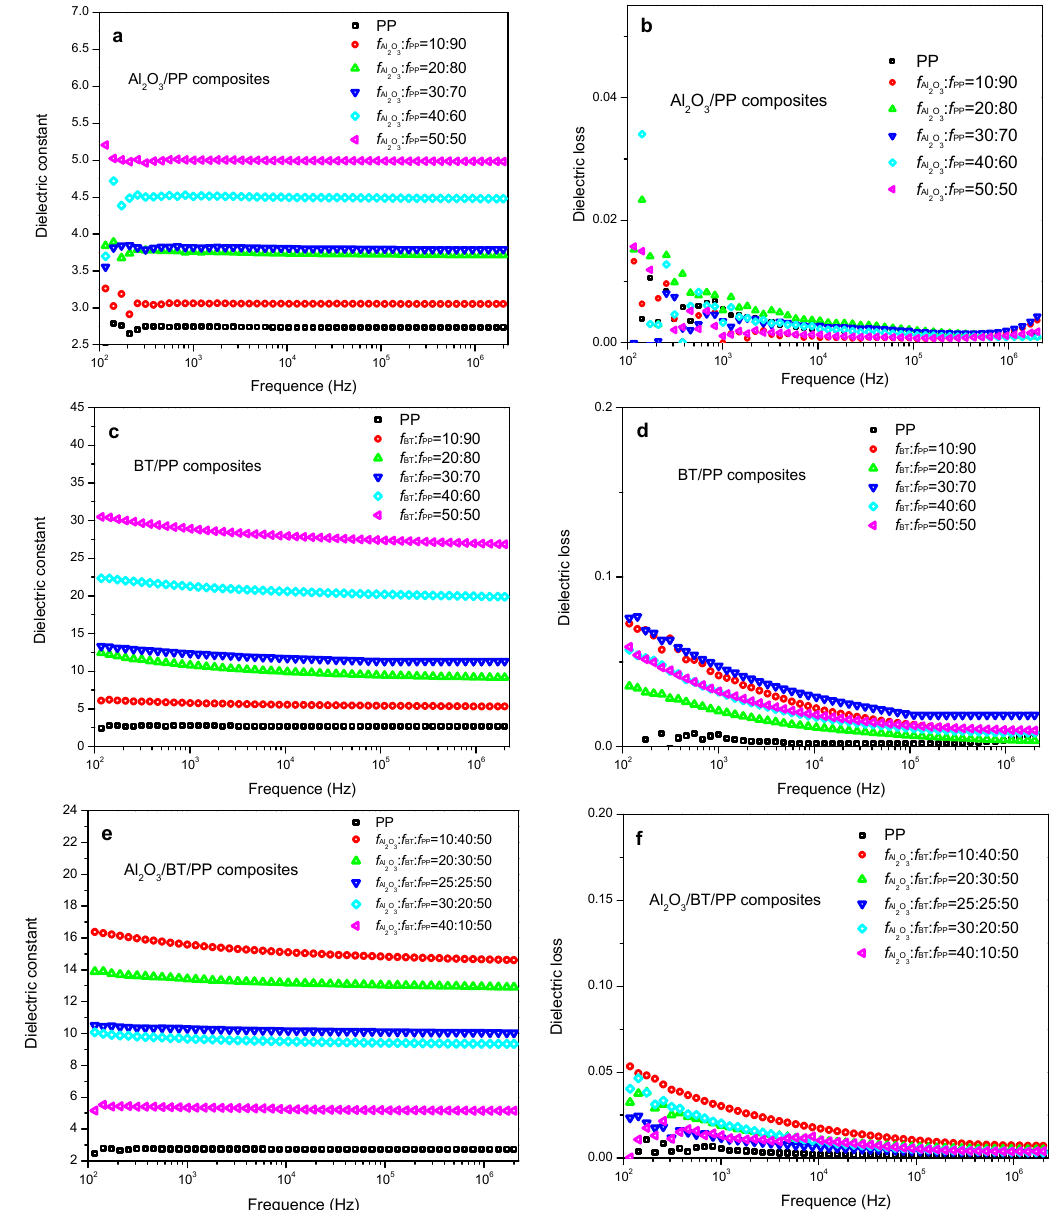
Figure 5. Dielectric constant/loss ‐ frequency curves of Al 2 O 3 /PP, BT/PP and Al 2 O 3 /BT/PP composites from 100 Hz to 2 MHz: ( a , b ) Al 2 O 3 /PP composites; ( c , d ) BT/PP composites; and ( e , f ) Al 2 O 3 /BT/PP composites.